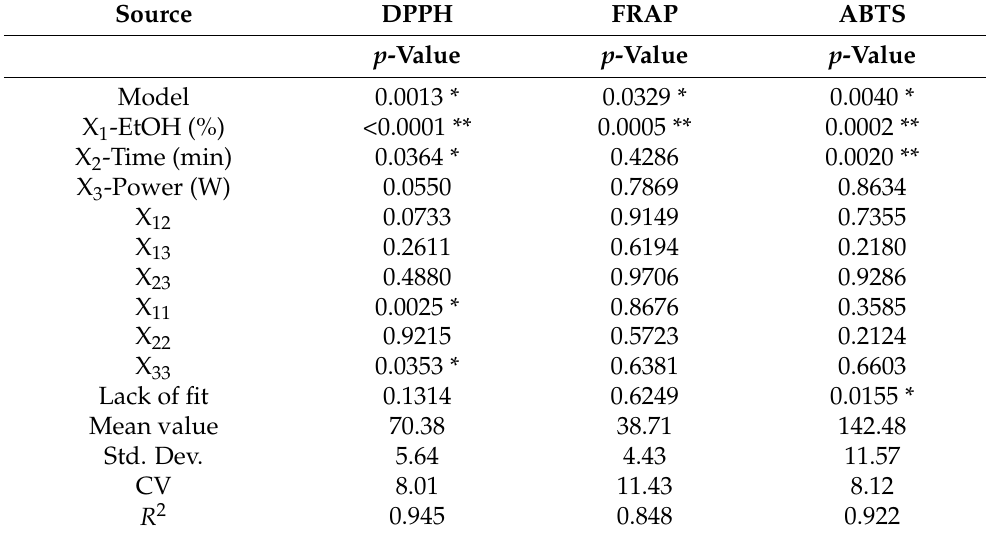
Table 2. Analysis of variance (ANOVA) of the investigated